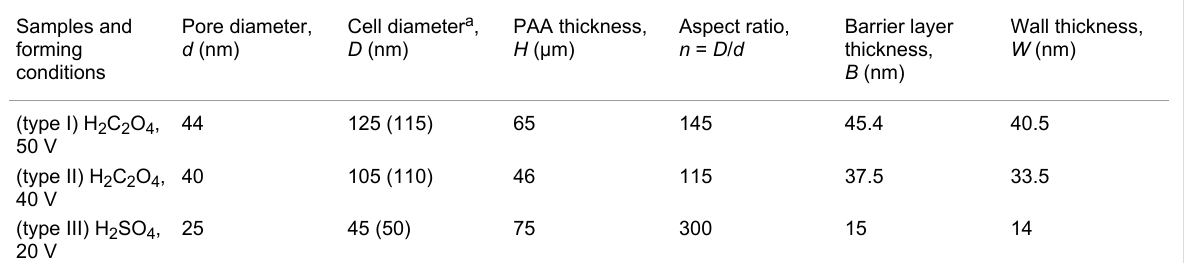
Table 1: Physical characteristics (average values) of the experimental samples (before etching, as-produced amorphous membrane). Samples and